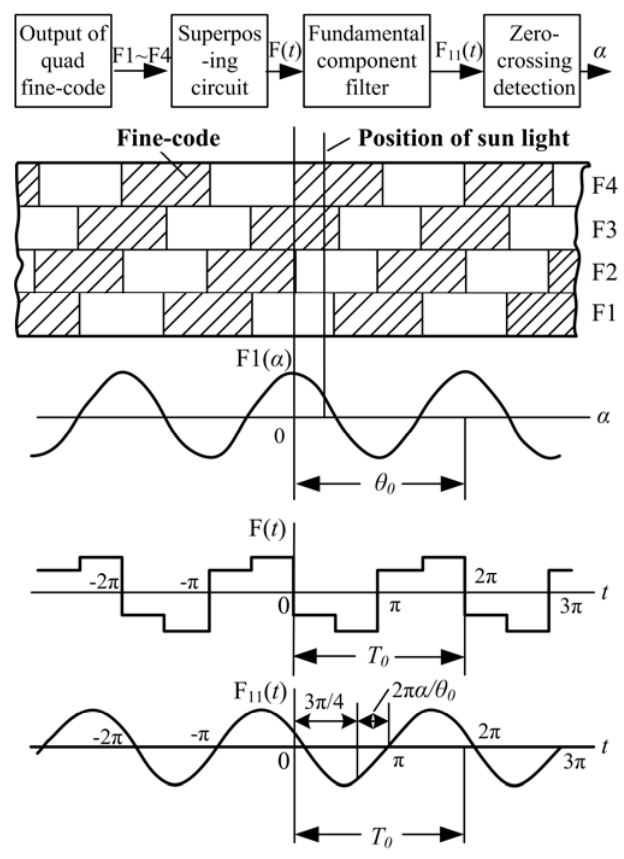
Figure 8. Working principle of fine-code processing